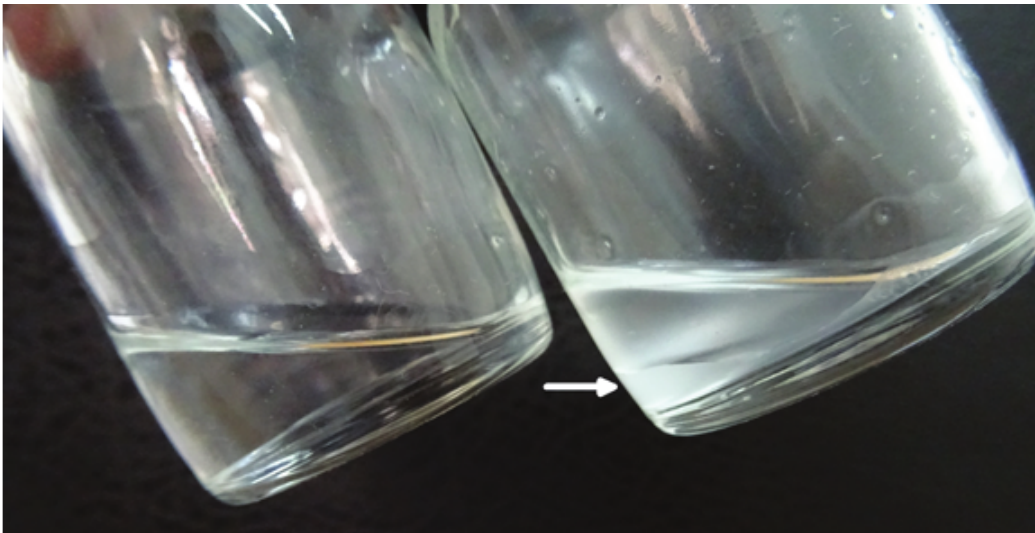
Figure 2. Left bottle: Unused clear silicone oil. Right bottle: Opaque silicone oil with infusion fluid at top. White opaque oil is settled at the bottom (white